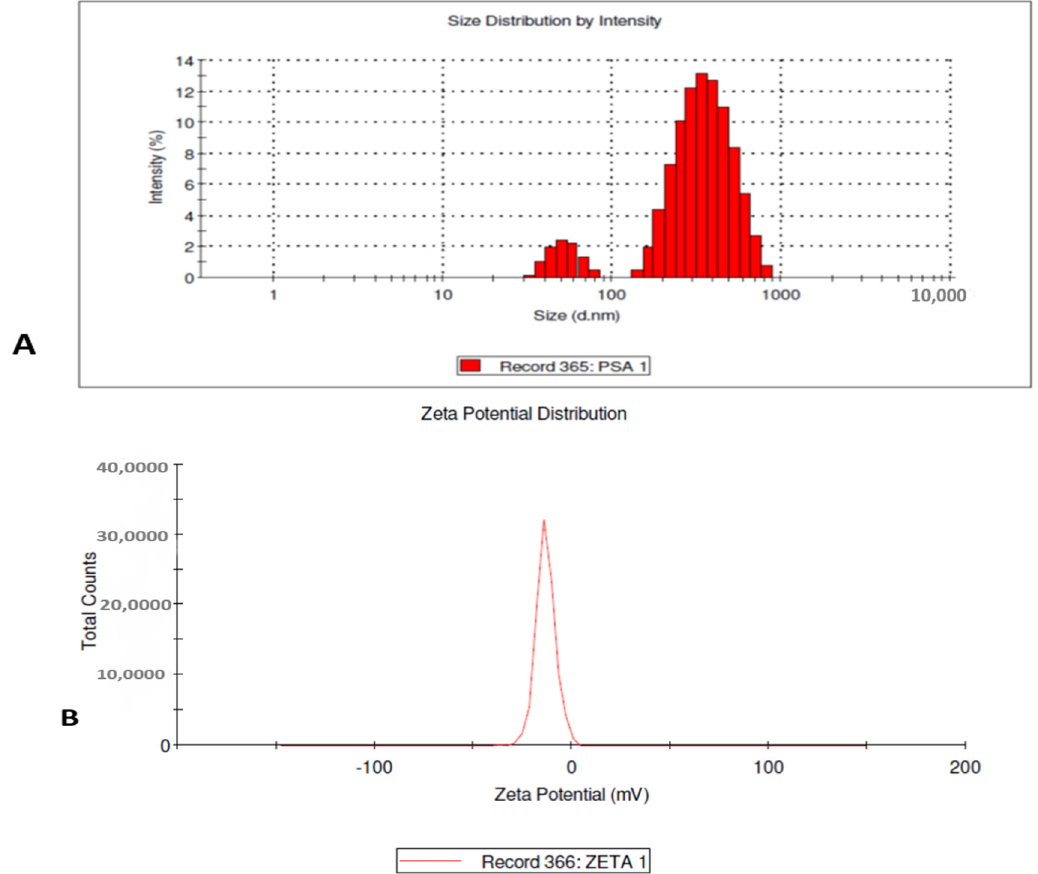
Figure 3. Dynamic light scattering (DLS) size distribution ( A ) and zeta potential analysis ( B ) of selenium nanoparticles synthesized using D. indica.